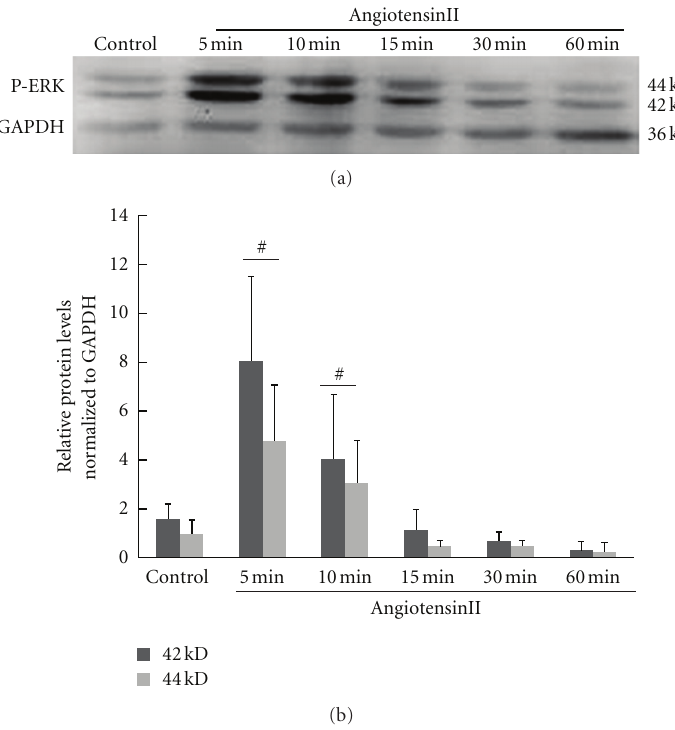
Figure 2: Time-dependent e ff ects of AngII on ERKs phosphorylation in cultured CMVECs. CMVECs were treated with AngII (10 − 7 M) for the indicated times and then collected and lysed for western blot analysis. (a) Representative immunoblots showing the expression of phosphor ERKs. GAPDH was used as a loading control. (b) Quantitative analysis for the expression of phosphor ERKs. Data represent mean ± SD obtained from 6 independent experiments ( n = 6); ∗ P < 0 . 05 versus control group (0min).